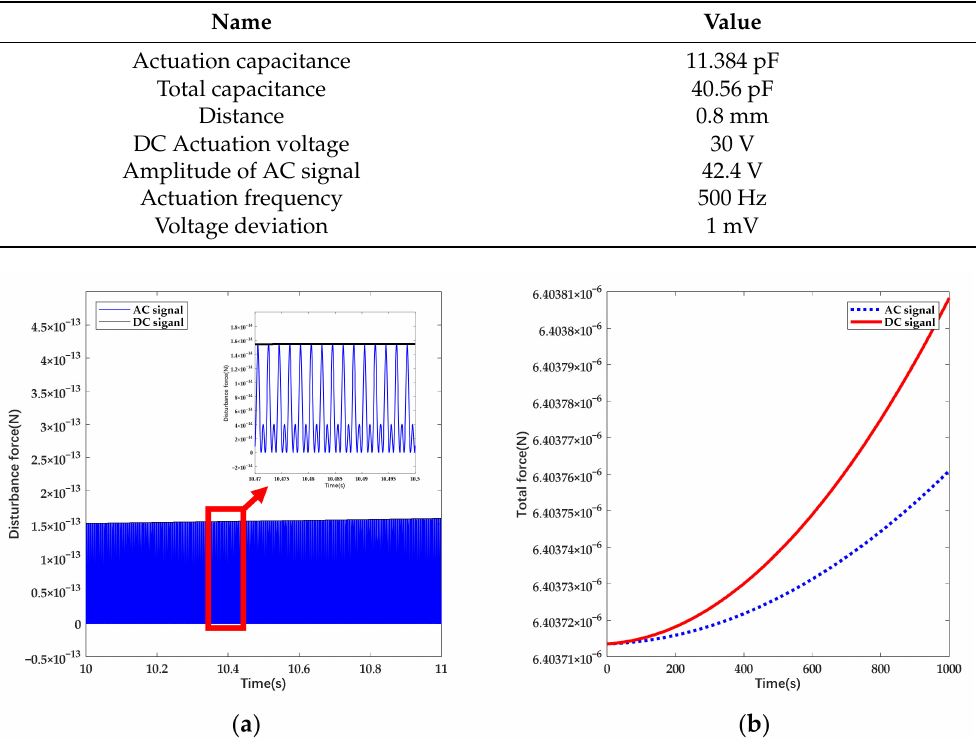
Table 1. Relevant ESA parameters used for evaluation.